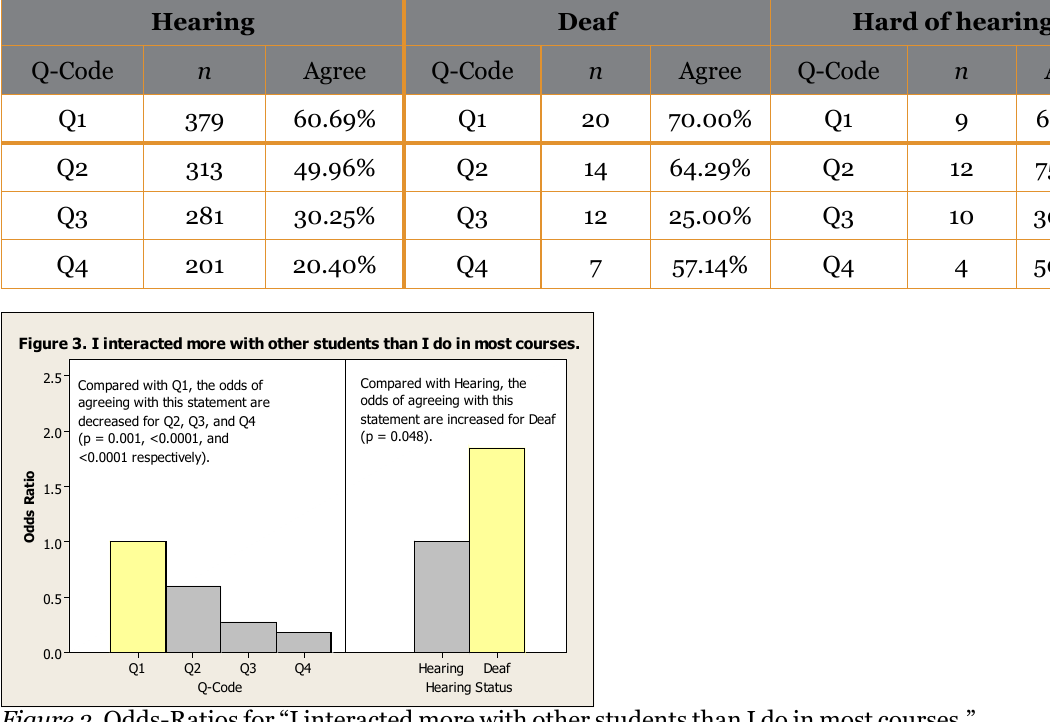
The following findings were found for “improved ability to communicate my ideas because of the online interaction in this course” (Table